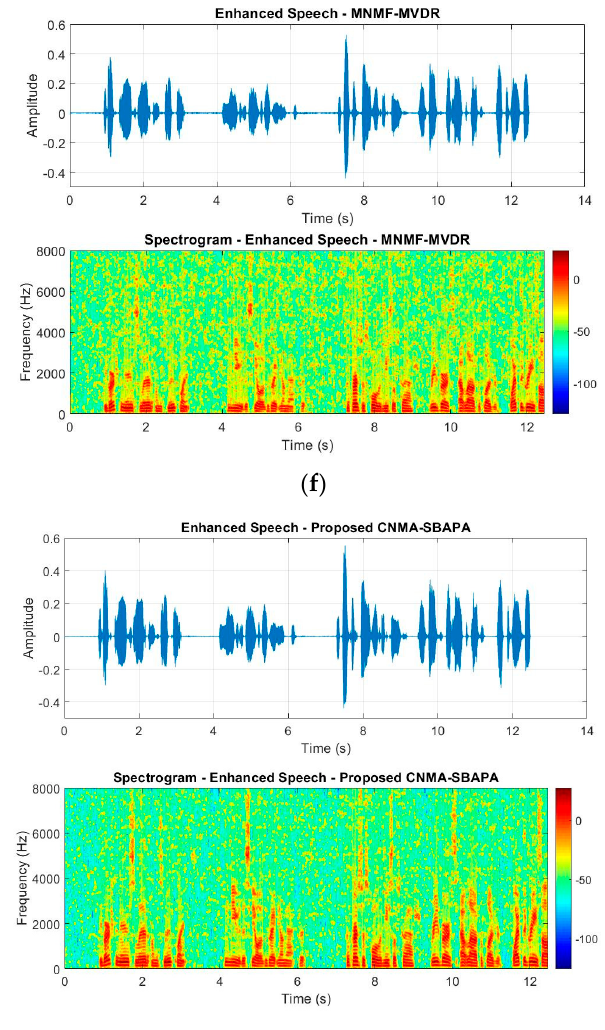
Figure 11. The time-domain and spectrum representation for ( a ) white noisy signal and enhanced signal by the ( b ) least mean square (LMS), ( c ) APA, ( d ) recursive least square (RLS), ( e )distributed multichannel Wiener filter (DB-MWF), ( f ) multichannel nonnegative matrix factorization-minimum variance distortionless response (MNMF-MVDR), and ( g ) proposed CNMA-SBAPA for SNR=0dB.